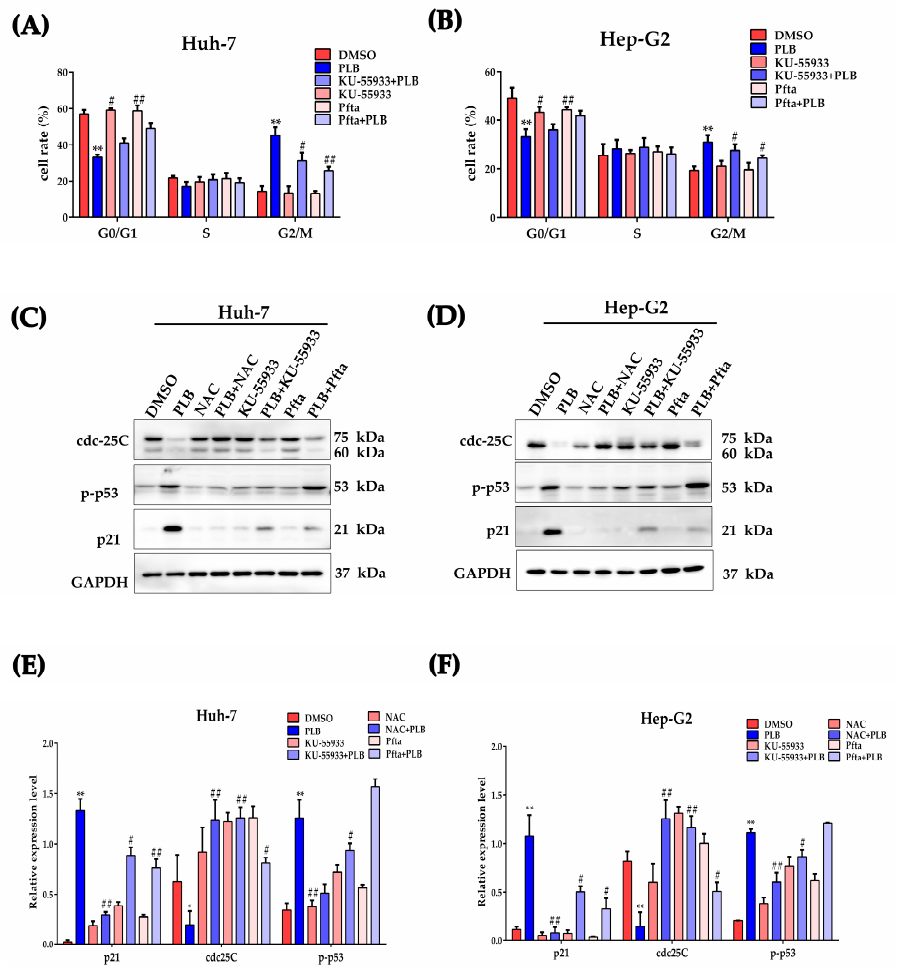
Figure 10. Involvement of ATM/p53 signaling pathway in PLB-induced G2/M cell cycle arrest. ( A , B ) HCC cells were pretreated with NAC (10 mM), KU-55933 (10 µ M) and Pifithrin- α (Pft α ,10 µ M) or not for 1 h, and 10 µ M of PLB was added into the medium for 12 h. Cell percentage at different cell cycle stages was analyzed based on the flow cytometry results. ( C , D ) The expression of cdc25C, p-p53 (Ser15) and p21 was determined by Western blot analysis. ( E , F ) Gray value statistical analysis of the indicated proteins. * p < 0.05, ** p < 0.01 compared to the DMSO group, # p < 0.05, ## p < 0.01 compared to the PLB treatment group; three independent experiments were performed.